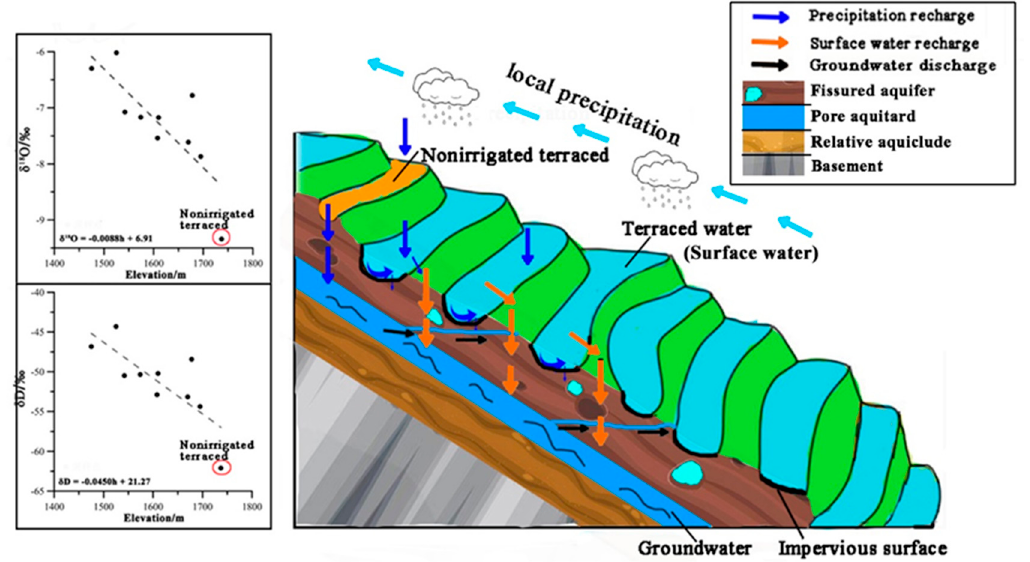
Figure 4. Spatial e ff ect on groundwater under the influence of farming activities (schematic Figure 4. Spatial effect on groundwater under the influence of farming activities (schematic diagram).